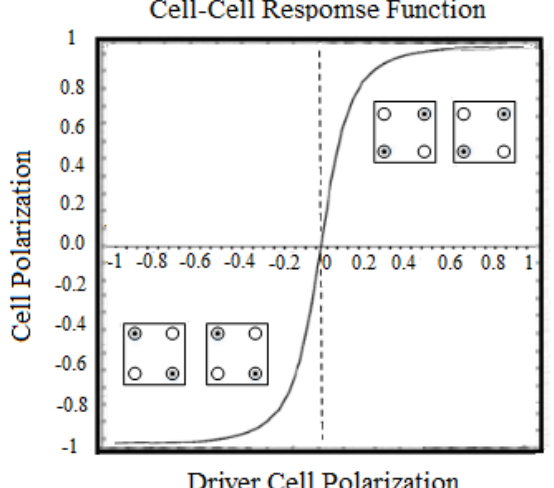
Figure 2. Behavior of adjacent cells.